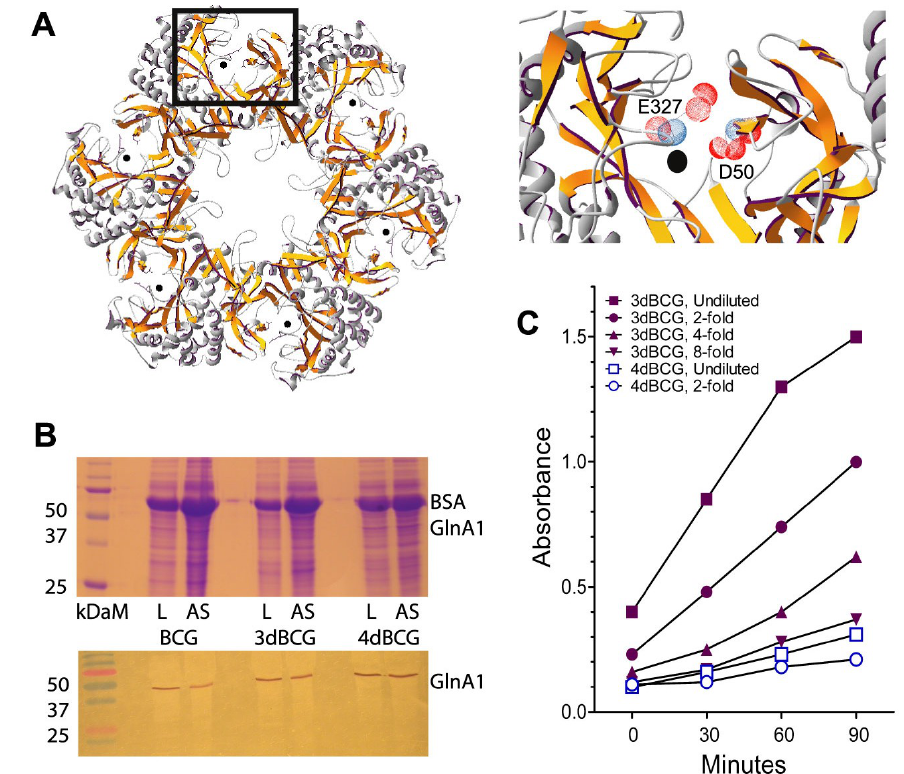
Figure 1. Construction of 4dBCG. ( A ) Hexameric ring representing half of the enzymatically-active dodecameric form of GlnA1 (left) and enlargement (right) of the area within the rectangle to show the deleted amino acids in relationship to the active site manganese atom, represented by the black dot, with amino acids numbered according to the glutamine synthetase of Salmonella [30]. As the active site comprises residues from adjacent monomers, insertion of one ∆D50∆E327 dnGlnA1 monomer into the ring is predicted to inactivate two active sites. ( B ) SDS-PAGE (upper) and immunoblot (lower) for GlnA1 of lysates of Bacillus Calmette-Guérin (BCG), 3dBCG and 4dBCG. Lanes are labeled on the figures as L (lysate) and AS (ammonium sulfate-treated lysate) for each strain, kDaM = Kilodalton markers. ( C ) Graph of a representative experiment comparing the glutamine synthetase activity of undiluted and diluted AS preparations from 3dBCG and 4dBCG as determined by monitoring A over 540